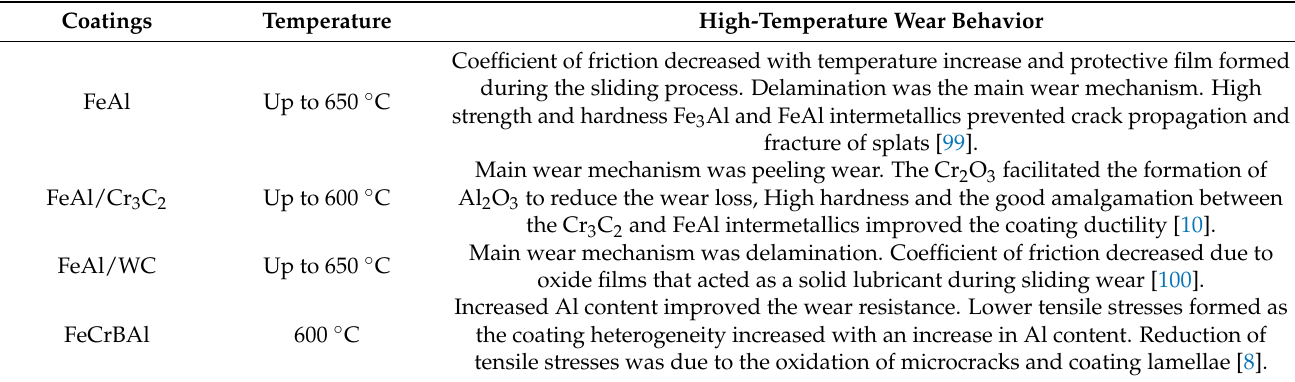
Table 7. Summary of the high-temperature wear behavior of arc-sprayed Fe-based coatings. Coatings Temperature High-Temperature Wear Behavior Coefficient of friction decreased with temperature increase and protective film formed during the sliding process. Delamination was the main wear mechanism. High FeAl Up to 650 ◦ C strength and hardness Fe 3 Al and FeAl intermetallics prevented crack propagation and fracture of splats [99]. Main wear mechanism was peeling wear. The Cr 2 O 3 facilitated the formation of FeAl/Cr 3 C 2 Up to 600 ◦ C Al 2 O 3 to reduce the wear loss, High hardness and the good amalgamation between the Cr 3 C 2 and FeAl intermetallics improved the coating ductility [10]. Main wear mechanism was delamination. Coefficient of friction decreased due to FeAl/WC Up to 650 ◦ C oxide films that acted as a solid lubricant during sliding wear [100]. Increased Al content improved the wear resistance. Lower tensile stresses formed as FeCrBAl 600 ◦ C the coating heterogeneity increased with an increase in Al content. Reduction of tensile stresses was due to the oxidation of microcracks and coating lamellae